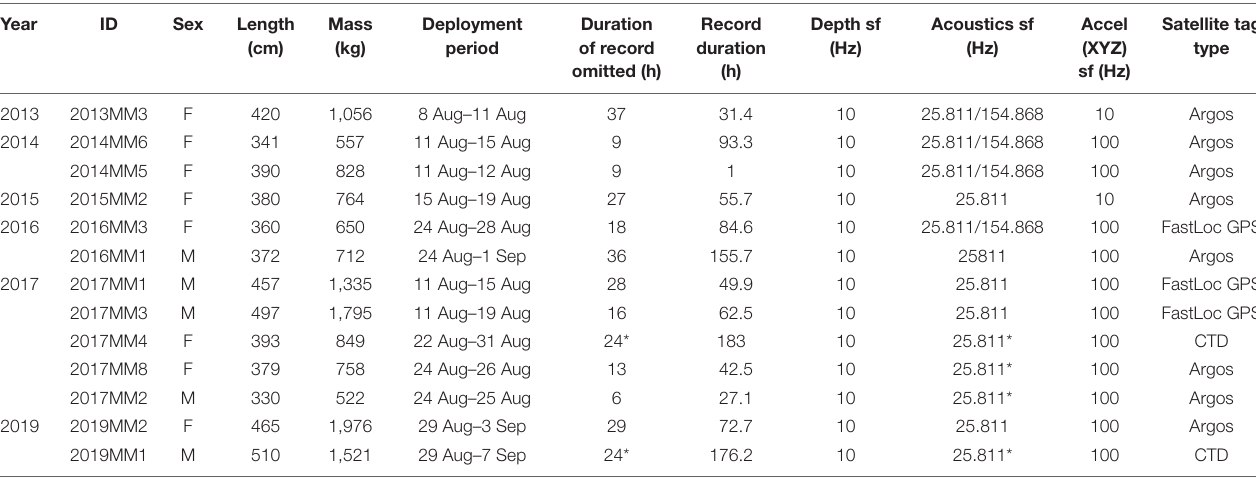
FIGURE 1 | Map of Greenland showing the Scoresby Sound fjord (red box) in East Greenland and a zoomed in map of the study area with the location of the field site, Hjørnedal, where tagging of narwhals took place. Tracks of three individuals [2016MM3 (female), 2017MM1 (male) and 2017MM3 (male)] used in the behavioral change point analysis ( bcpa ), that incorporated horizontal and vertical movement, are shown. TABLE 1 | Description of the individual deployments and